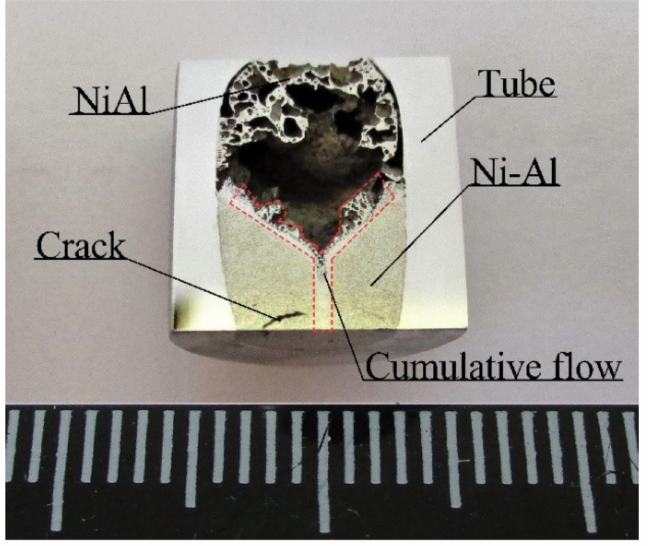
Figure 10. Photograph of longitudinal section from segment II of ampoule No.